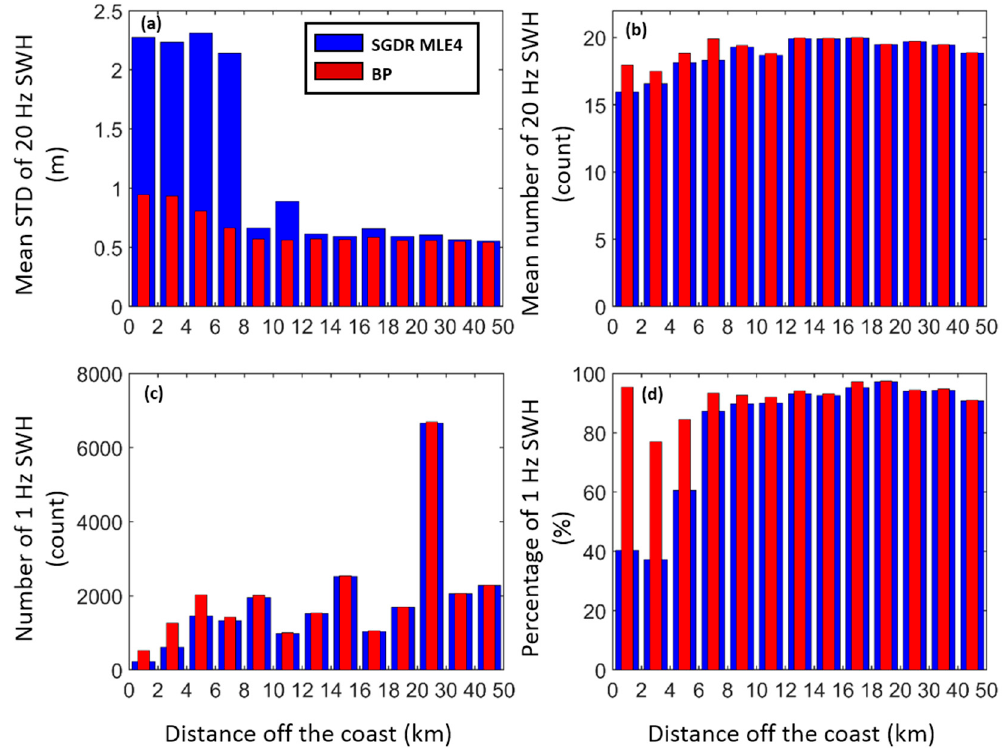
Figure 2. Comparison between retracked SWHs from the BP and the SGDR MLE4 based on the distance to the coast. ( a ) The mean STDs of 20 Hz SWHs; ( b ) The mean number of 20 Hz SWHs; ( c ) The total number of retrieved 1 Hz SWHs; ( d ) The percentage of retrieved 1 Hz SWHs.